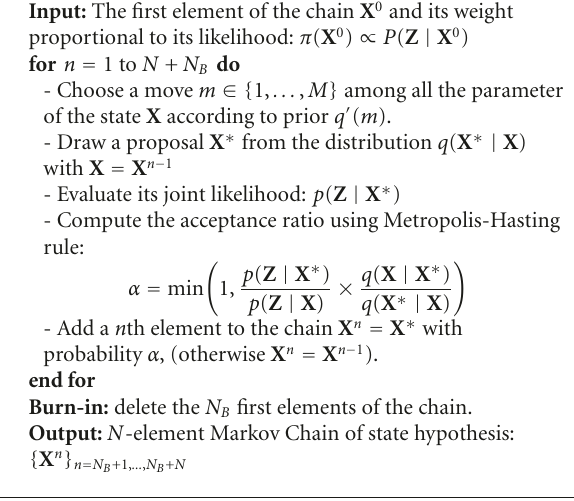
Algorithm 1: MCMC